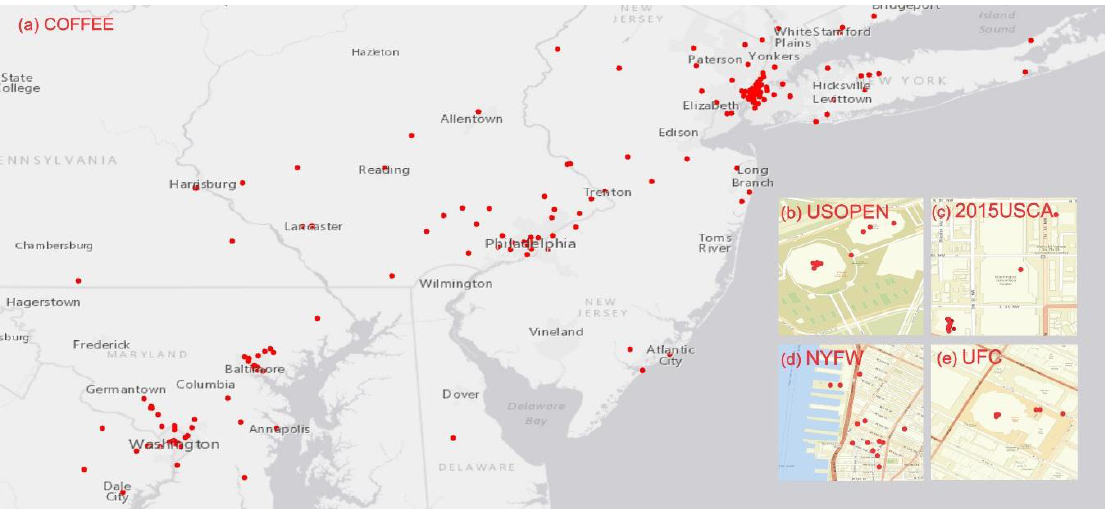
Figure 11. Snapshots of the extracted regional and local event in the study area. ( a ) National Coffee Day. ( b ) US Open Tennis Championship (USOPEN) in Arthur Ashe Stadium. ( c ) United States Conference on AIDS (USCA) in Washington DC. ( d ) New York Fashion Week. ( e ) Martial arts event UFC 205.